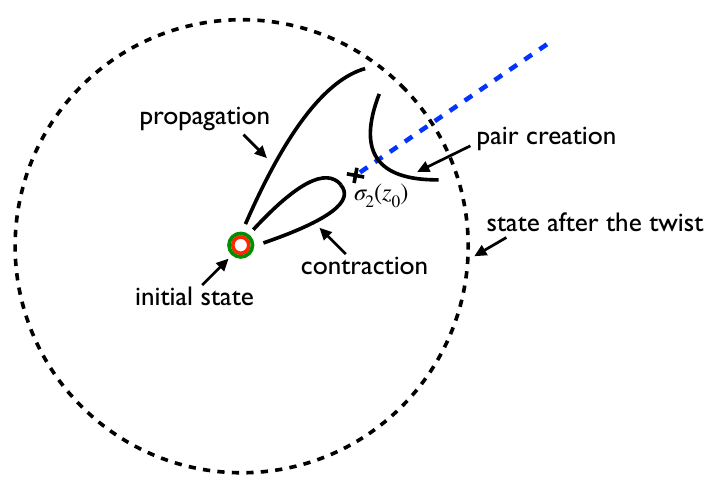
Figure 2 . The three basic rules to compute the effect of a twist